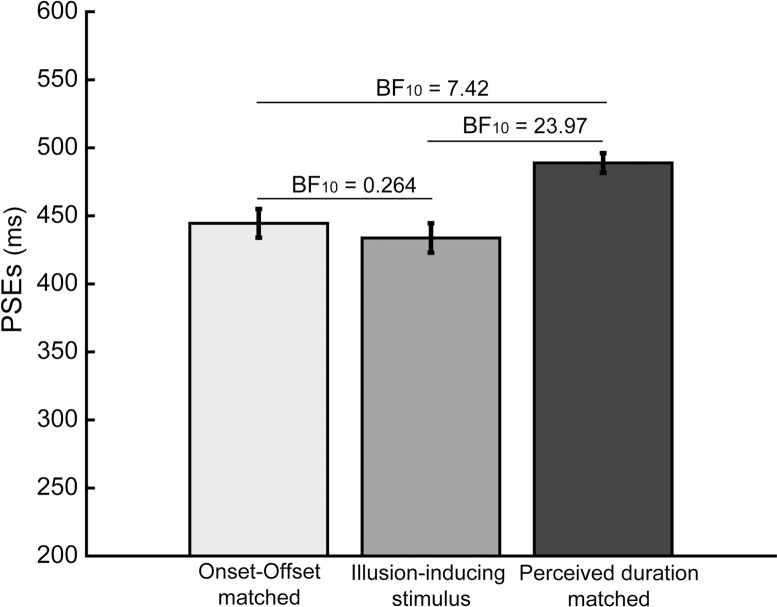
Average PSEs for each of the three adaptation conditions.Average PSEs for when participants adapted to the onset-offset matched stimulus (300 ms, static), the illusion-inducing stimulus (300 ms, 8.33Hz), and the perceptually matched stimulus (M = 572.60 ms, static). BFs are given for all Bayesian paired sample t-tests with BF10 > 3 indicating evidence that the PSEs are different and BF10 < 1/3 indicating evidence that they are not. Error bars reflect confidence intervals based on the within-subject variability of the data [33,34].